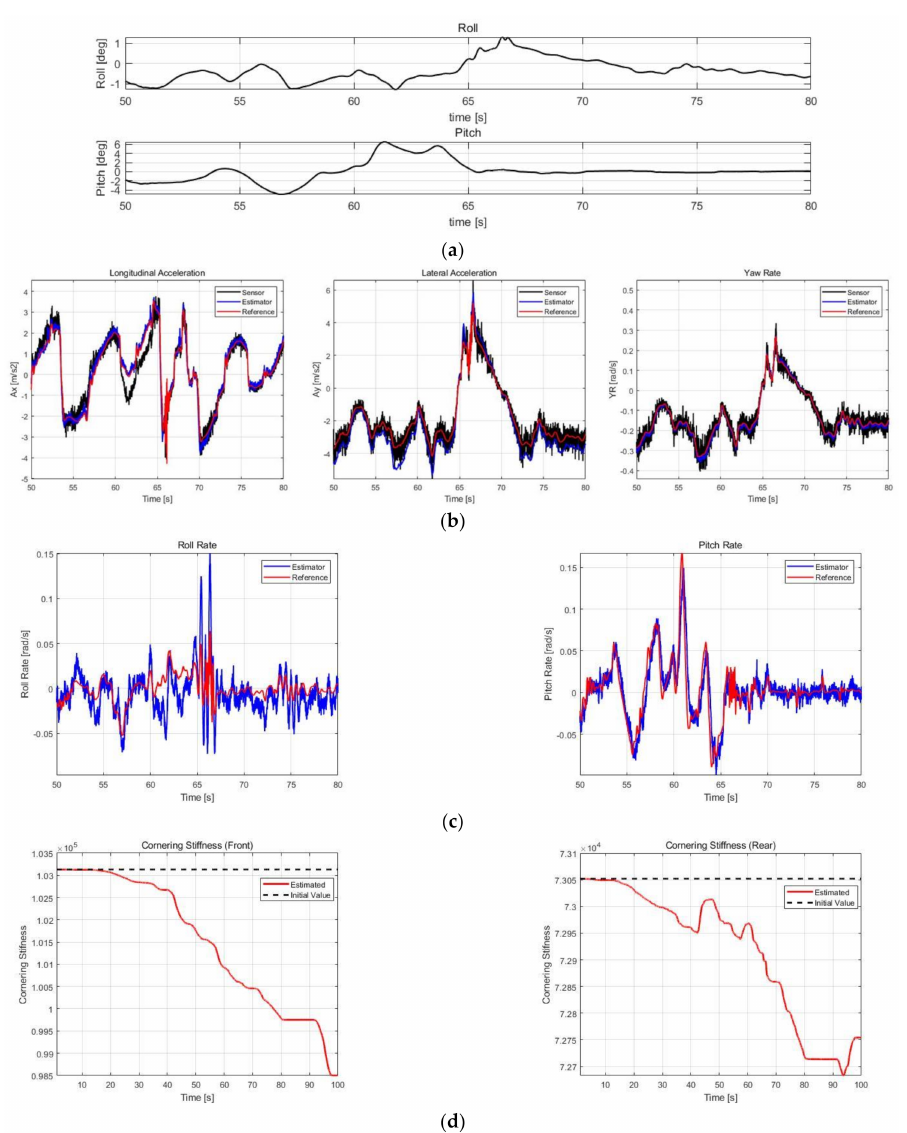
. ψ estimation results.